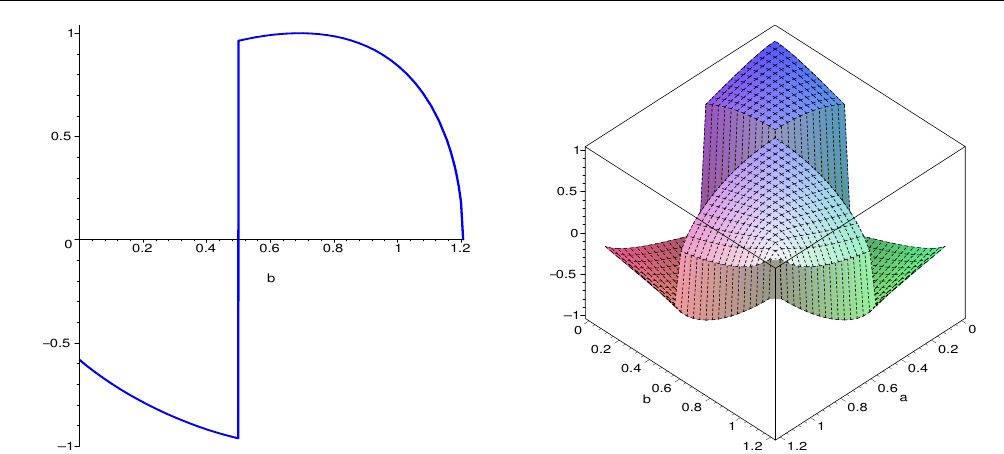
Fig. 2: Asymptotic correlation coefficient of the number of nodes at two levels. The discontinuity of the sign at 1 is visible from both figures. Here α = log 2 ≈ 0 . 69 (left) and a 3-dimensional rendering (right) of 2 p f ( α, β ) / f ( α, α ) f ( β, β )